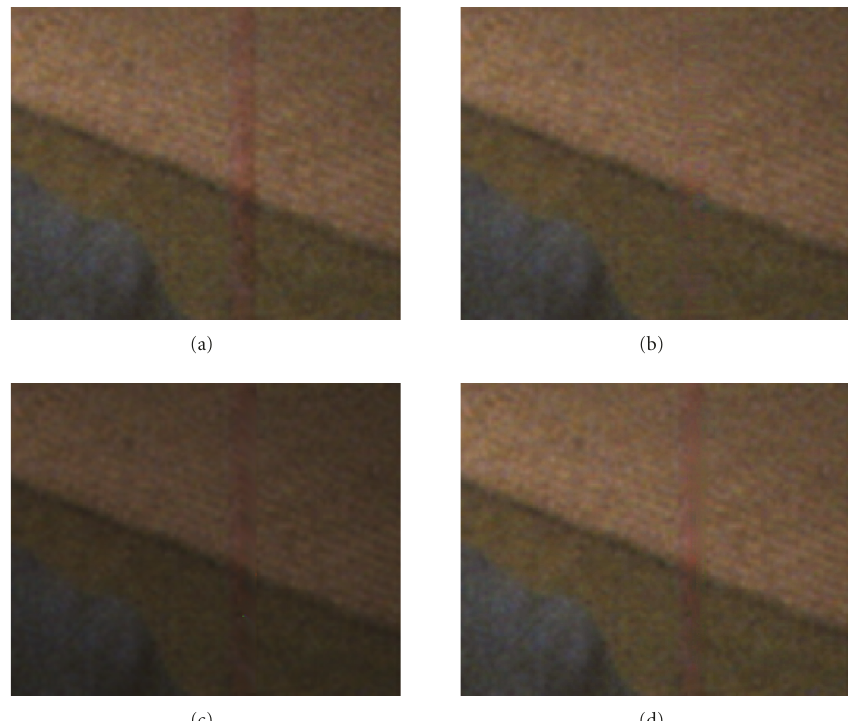
Figure 8: Zoom of the red scratch in Figure 2(a) restored using the proposed algorithm (b), the method in [1] (c) and the method in [7]